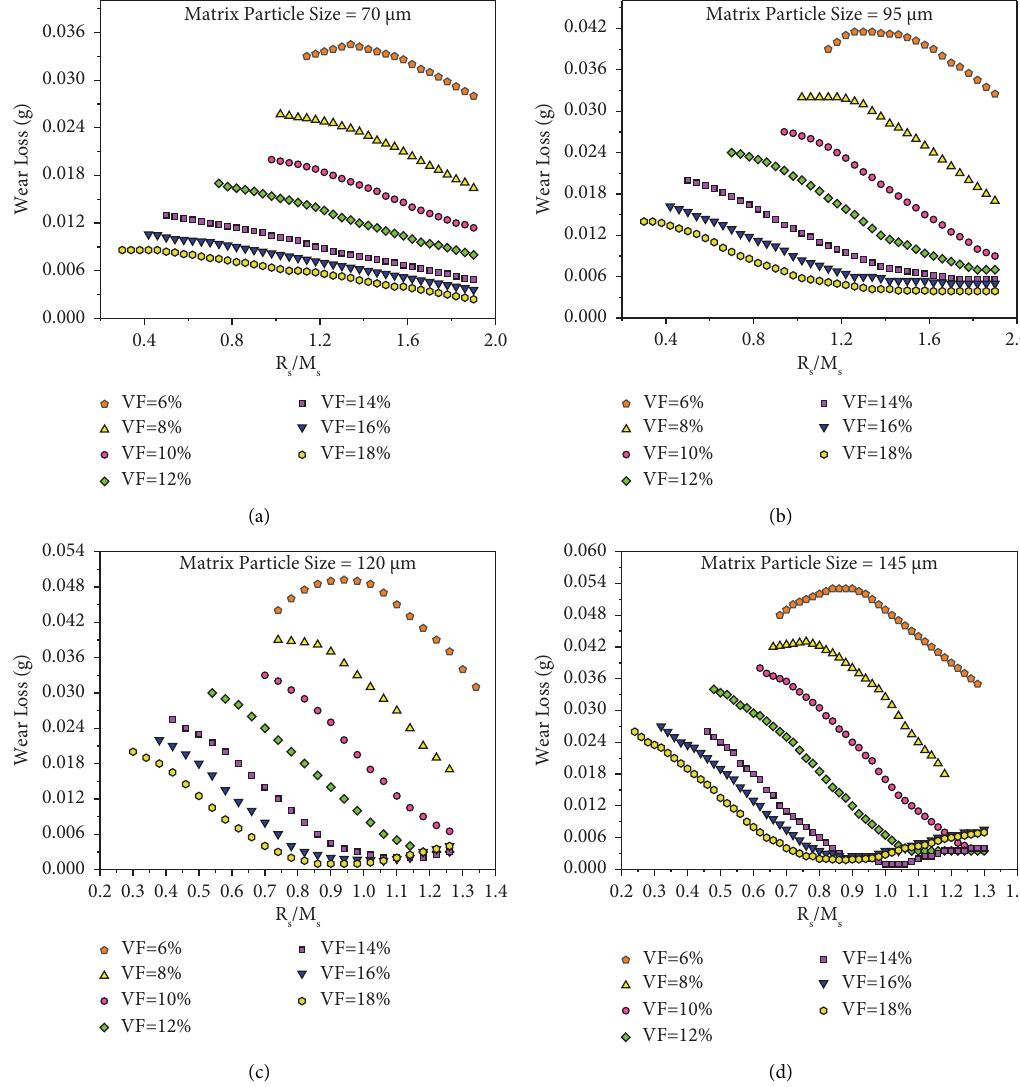
Figure 6: Predicted wear loss for various matrix particle sizes (a) 70 μ m, (b) 95 μ m, (c) 120 μ m, and (d) 145 μ